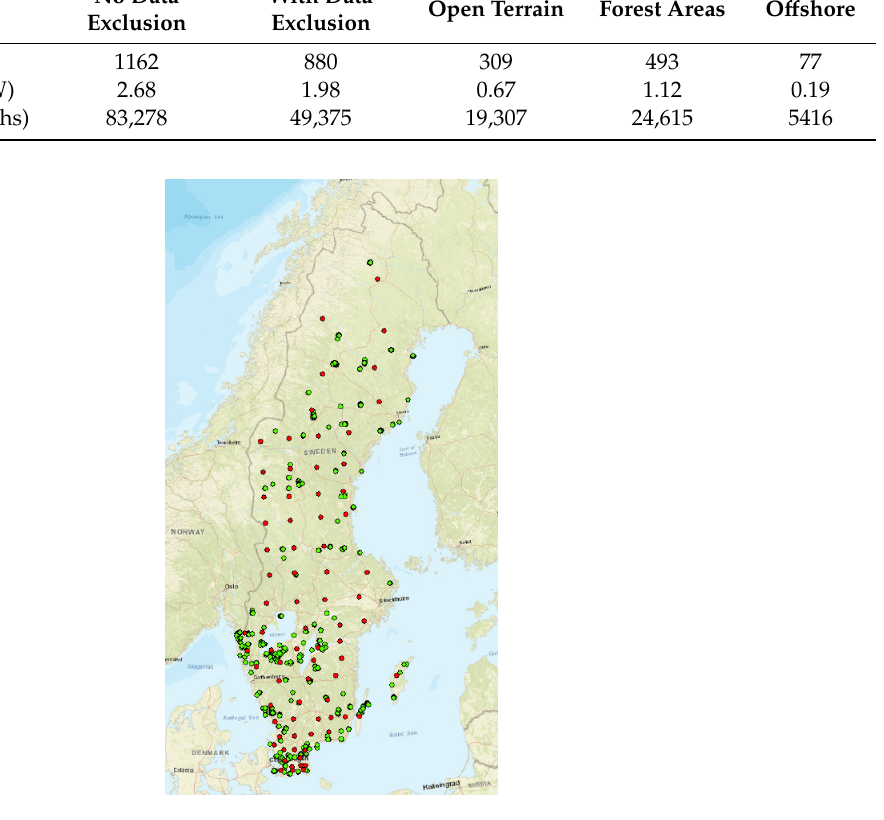
Figure 1. Locations of wind turbines included in this study (green). Locations of index sites used for normal wind-year normalization (red); see Section 3.2.